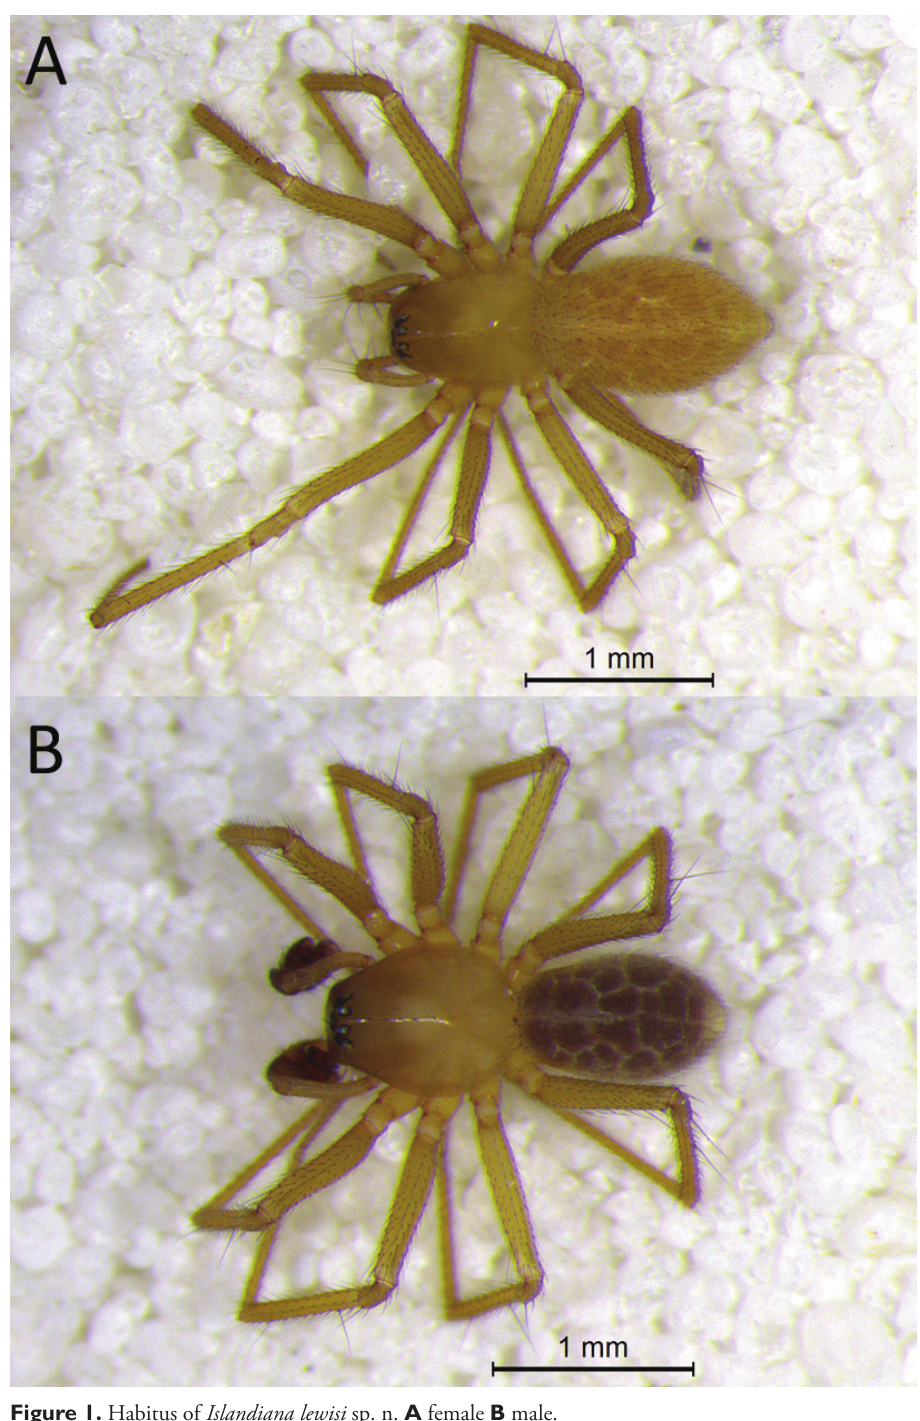
Figure 1. Habitus of Islandiana lewisi sp. n. A female B